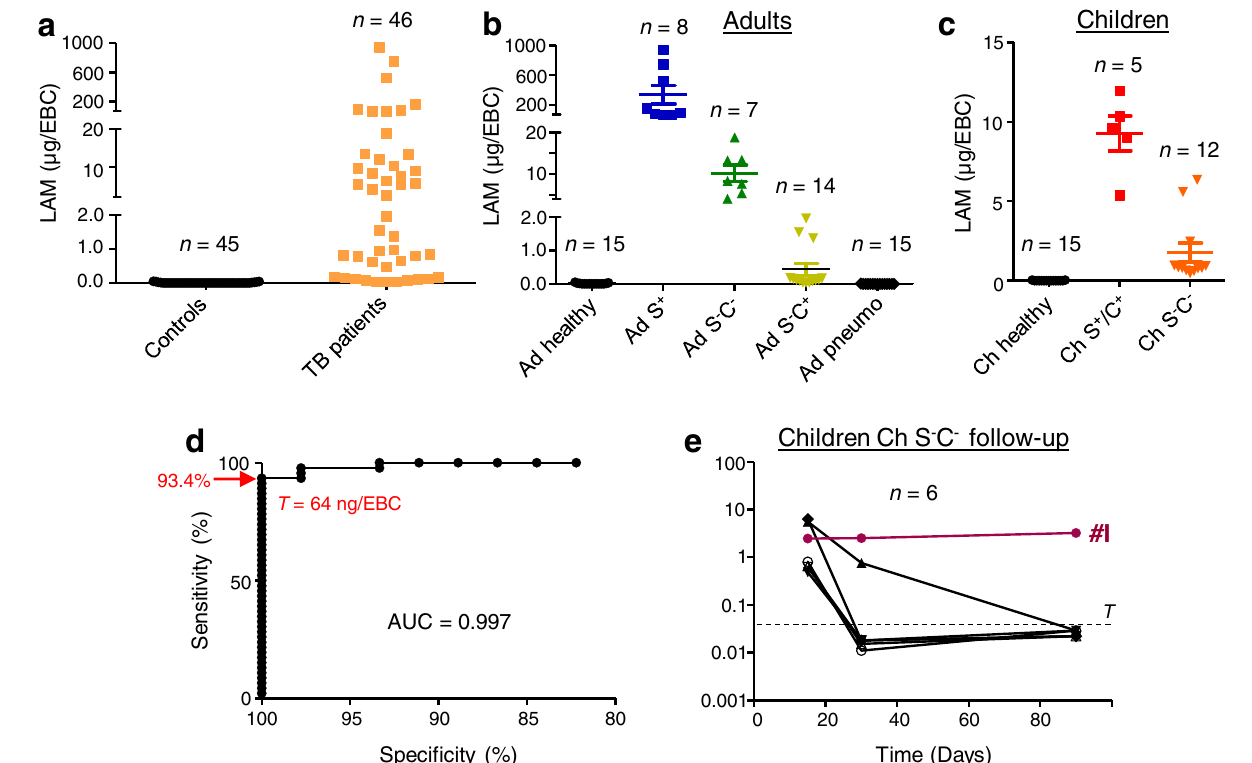
Fig. 1 | Quanti fi cation of LAM in EBC from TB patients and control individuals listedinTable1. QuantityofLAMinEBCsamplesfromallthesubjectsinvolved( a ), adults ( b ), and children ( c , e ) was determined by an immunoassay using the CS-35 anti-LAM antibody. A receiver-operating characteristic (ROC) analysis of the LAM